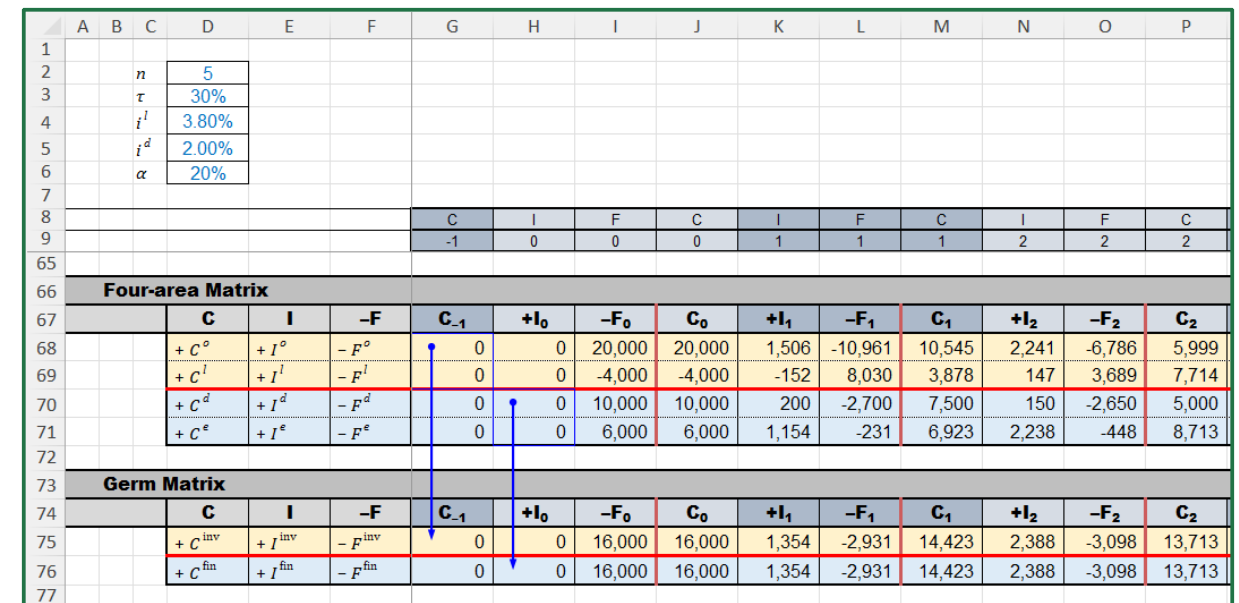
Figure 31. Germ matrix (“SplitScreenStrip” sheet). The rows with the same color in the Four-area Matrix are consolidated into one row of the same color in the Germ Matrix.